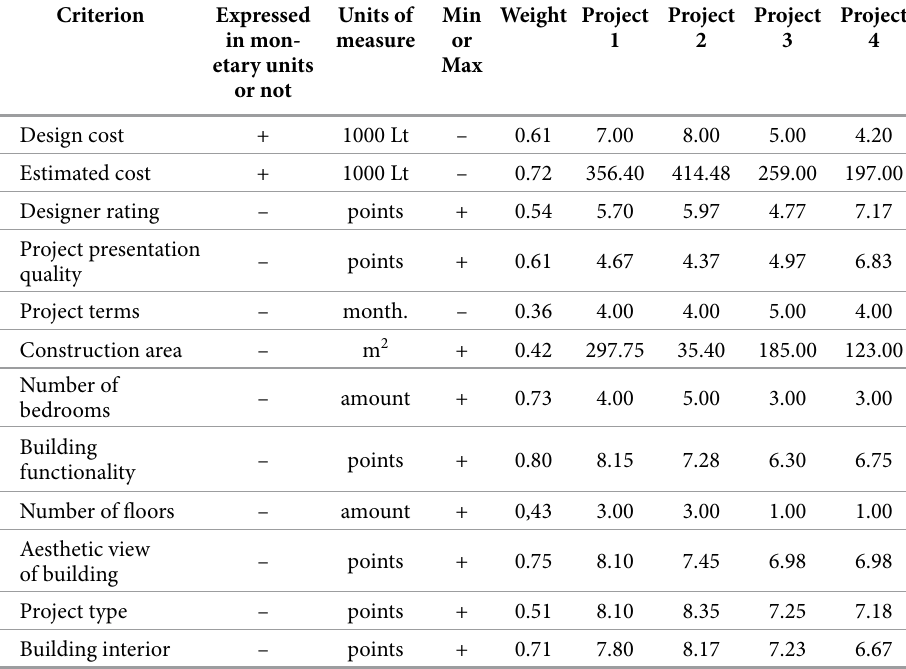
Table 1. Alternatives of architectural solutions of the projects prepared for multiple criteria evaluation